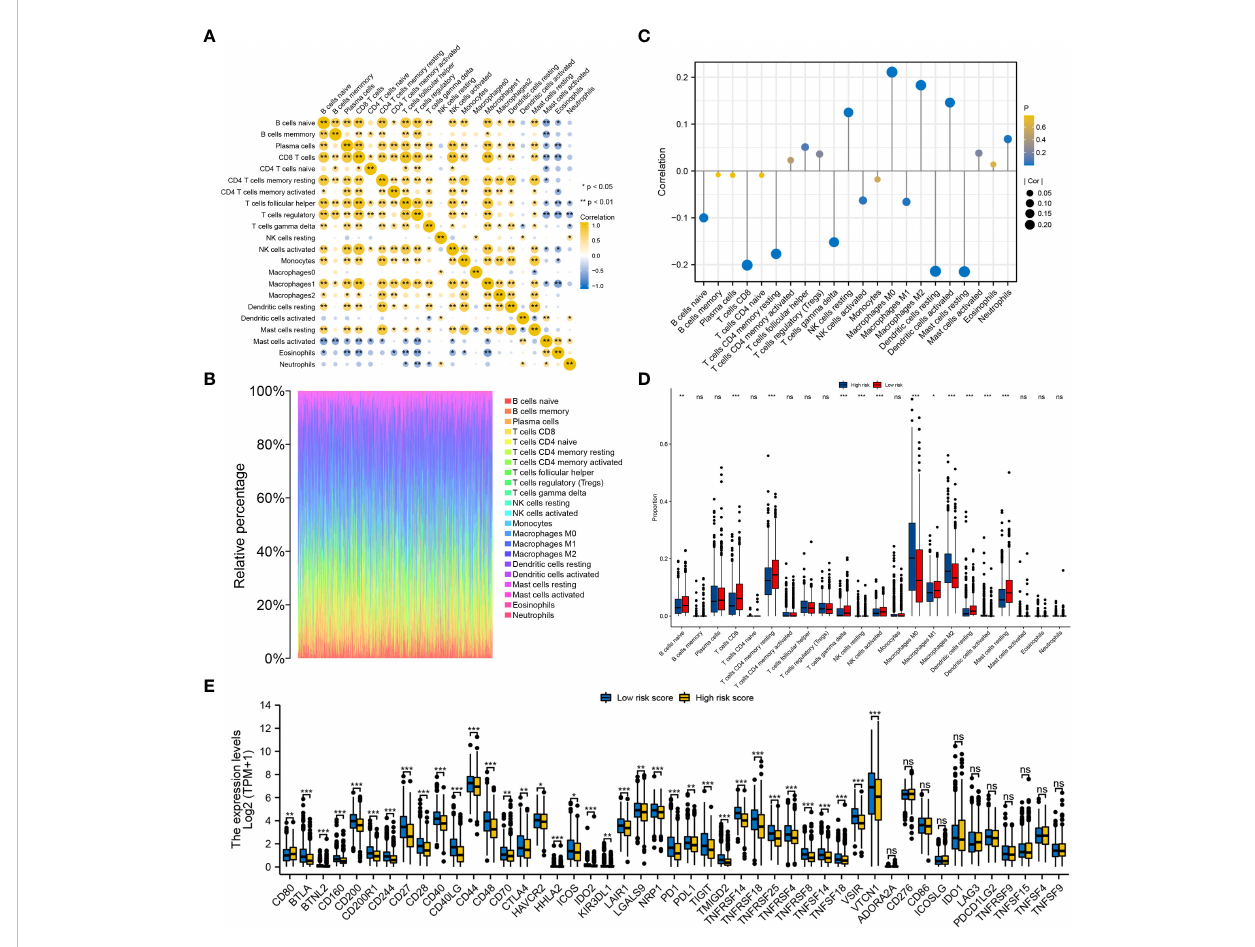
FIGURE 10 Evaluation of the in fi ltration levels of immune cells and the expression pattern of immune checkpoints between the low- and high-risk groups. (A) Correlation among the in fi ltration levels of 22 types of immune cells in BRCA. (B) In fi ltration levels of immune cells in each BRCA sample. (C) Correlation between the risk score and in fi ltration levels of the 22 types of immune cells. (D) Differences in the in fi ltration levels of the 22 types of immune cells between the two risk groups. (E) Differential expression of 47 immune checkpoints between the low- and high-risk groups. ‘ *** ’ indicates P -value < 0.001. "ns" represents non-signi fi